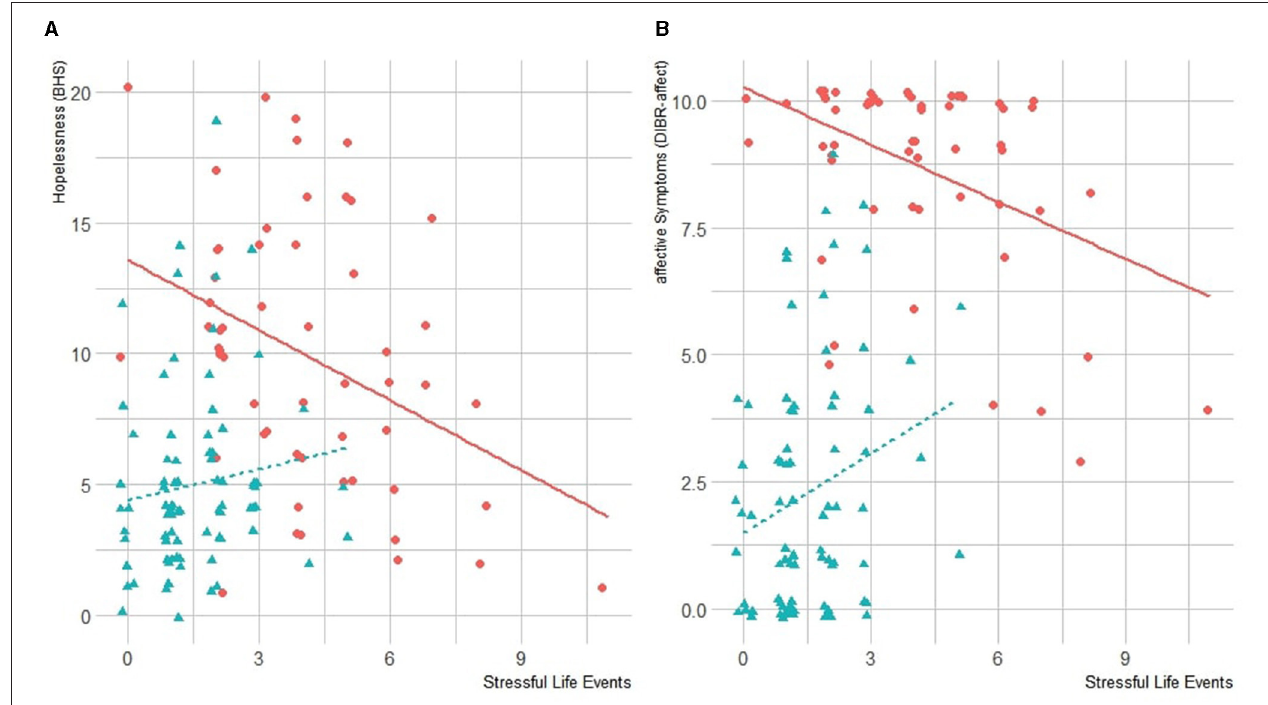
FIGURE 2 | (A) Correlation between SLEs and hopelessness. (B) Correlation between SLE and DIBR-affect in BPD and HC groups. BHS, Beck Hopelessness Scale; BPD, borderline personality disorder; DIBR, Diagnostic Interview for Borderline—Revised; HC, healthy controls; SLE, stressful life events.